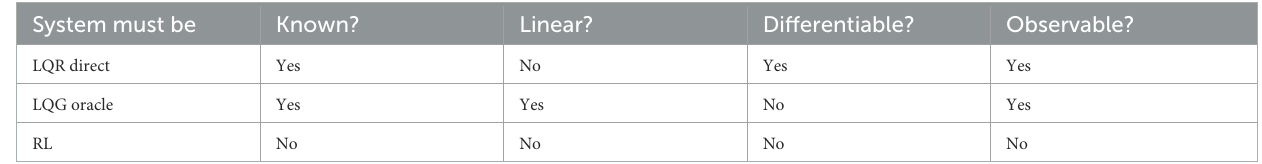
TABLE 1 Selecting a training method for the RNN neural system depends on properties of the environment. System must be Known?